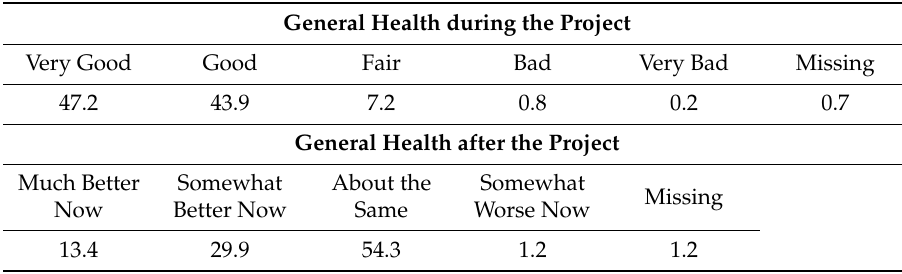
Table 1. General health during and after the project.